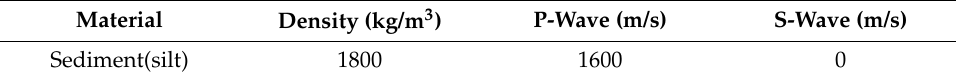
Figure 12. Vibration velocity amplitude of the OBS under incident angle of 0° .